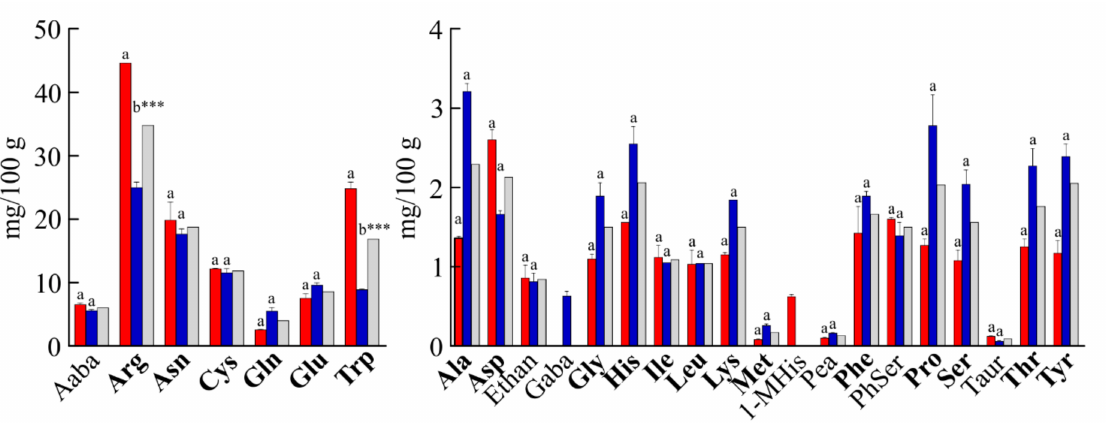
Figure 3. Free amino acid composition of Valle Agricola chickpeas. Values are means ( ± SD) of triplicate analyses ( n = 3) and are expressed on dry-weight basis (mg/100 g). Valle Agricola chickpea seeds were collected in the years 2017 (red) and 2018 (blue), in grey the average values. Protein amino acids are highlighted in bold. Code for non-protein amino acids: Aaba, α -Aminobutyric acid; Ethan, ethanolamine; GABA, γ -aminobutyric acid; 1-MHis, 1-methyl-L-histidine; Pea, phosphorylethanolamine; PhSer, phosphoserine; Taur, L-taurine. Different letters (a, b) indicate a significance difference among levels of free amino acids ( p < 0.05) by Bonferroni post-test. *** indicates significant difference at p <